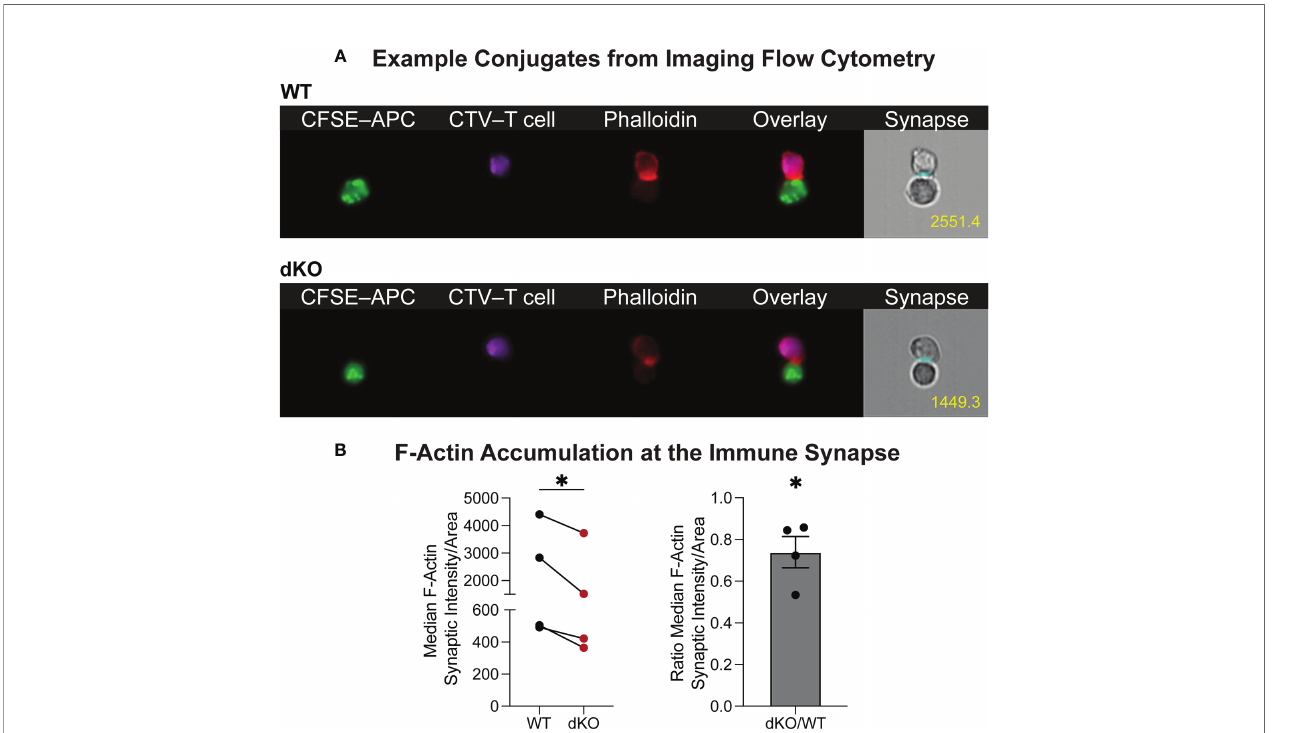
FIGURE 6 | Ena/VASP proteins contribute to actin rearrangement at the immunological synapse. CTV-labeled WT or EVL/VASP dKO naïve OT-I T cells were conjugated with antigen-loaded CFSE-labeled APCs and stained for F-actin. (A) Representative ImageStream images of WT and EVL/VASP dKO T cell – APC conjugates stained for phalloidin. Number in yellow indicates phalloidin GMFI measured at the immune synapse. (B) Left; quanti fi cation of median phalloidin intensity at the immunological synapse divided by the synapse area. Right; quanti fi cation of the EVL/VASP dKO/WT fl uorescence intensity ratio at the synapse. Data represent averages from 4 independent experiments with ~1000 – 7000 conjugates analyzed per sample. Statistics were performed using one-tailed paired t test and one sample t test compared to a hypothetical value of 1.0; * is p <